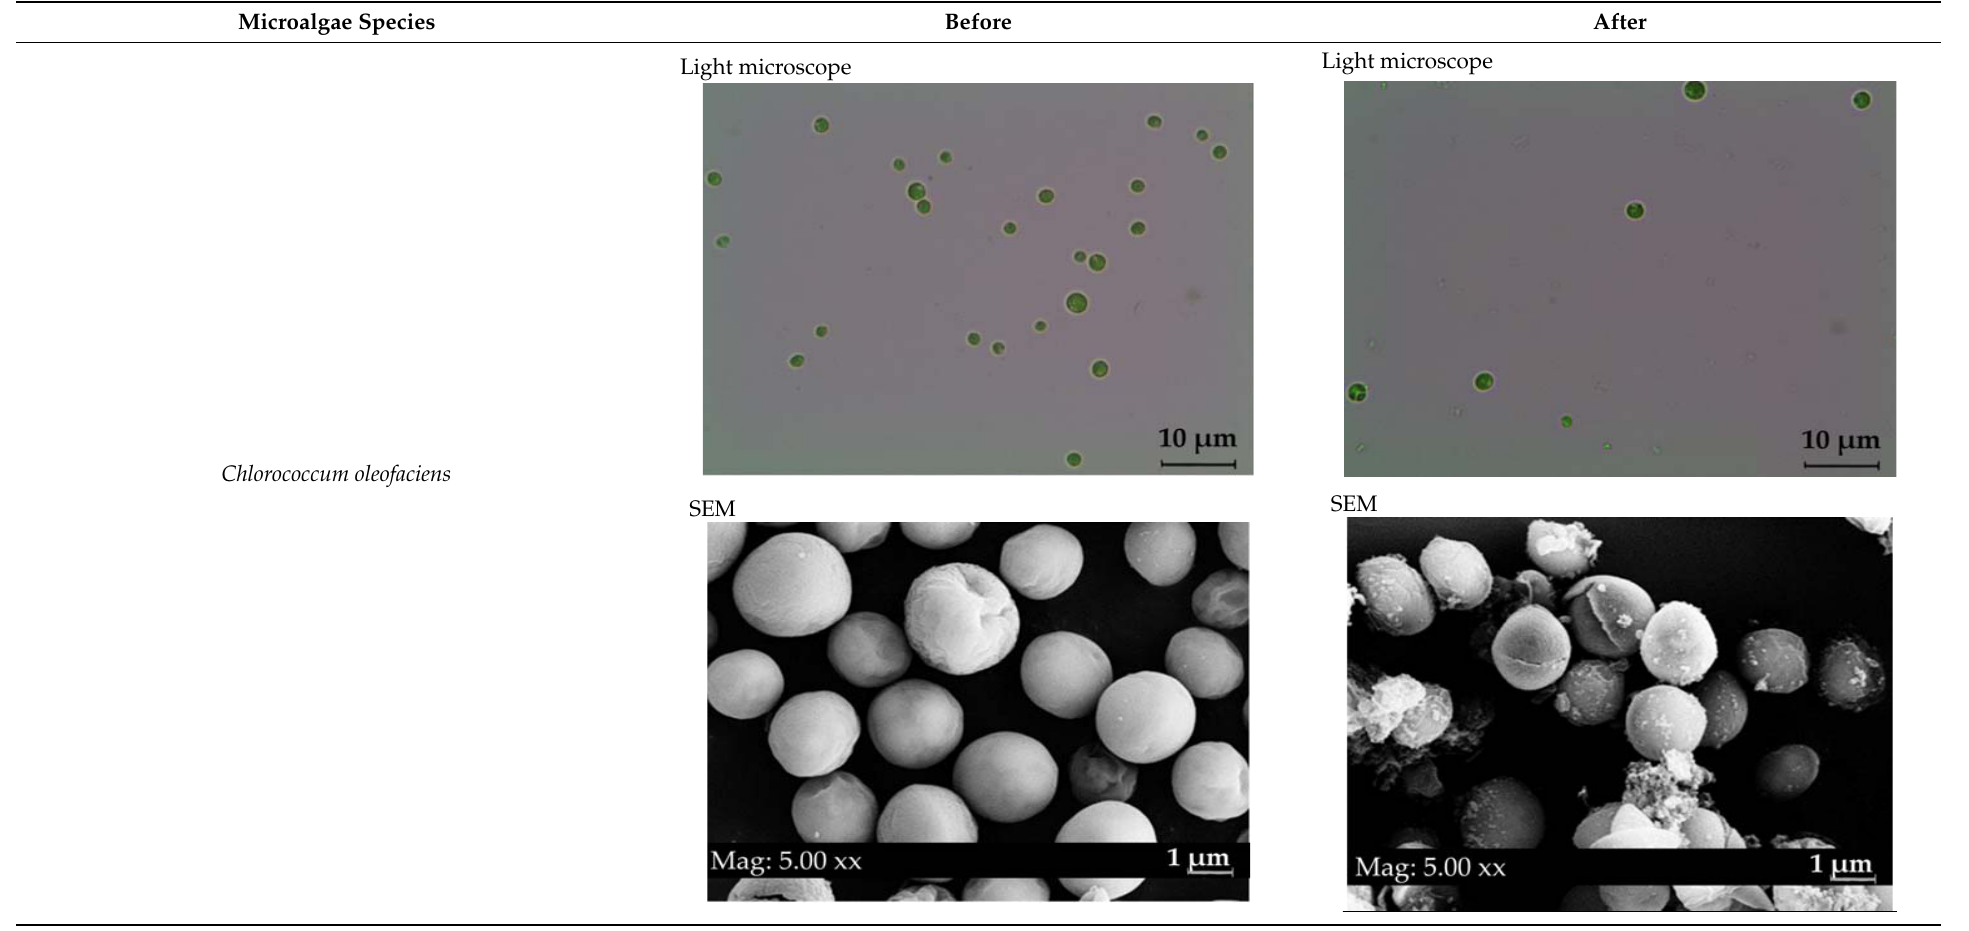
Table 4. Morphology of the three green microalgae before and after growing in LABT-POME (75%) observed with a 40× objective light microscope and SEM.